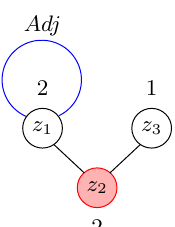
Figure 8 . P (3) quiver with SU(2) 2 (cid:24) = SO(4) global symmetry, b = (cid:0) 1, dim H M C = [2 ; 1]